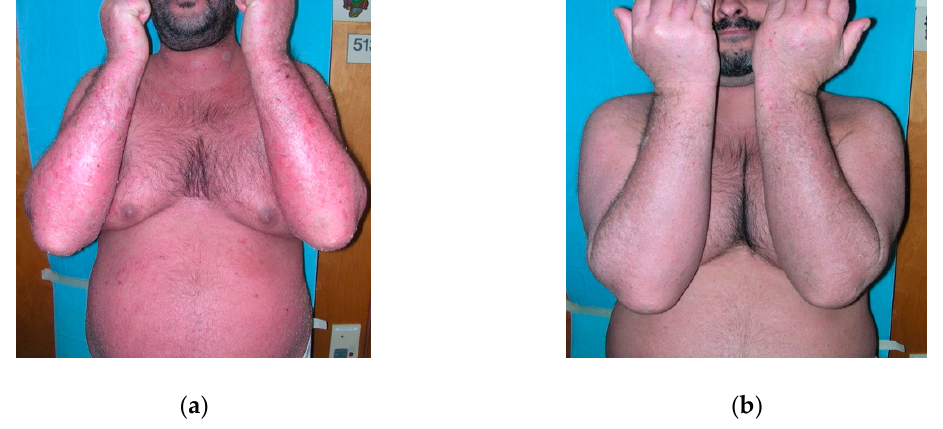
Figure 1. A 34-year-old patient with erythrodermic psoriasis that underwent secukinumab therapy. ( a ) Erythrodermic patient before treatment, ( b ) Patient after three weeks of secukinumab treatment.